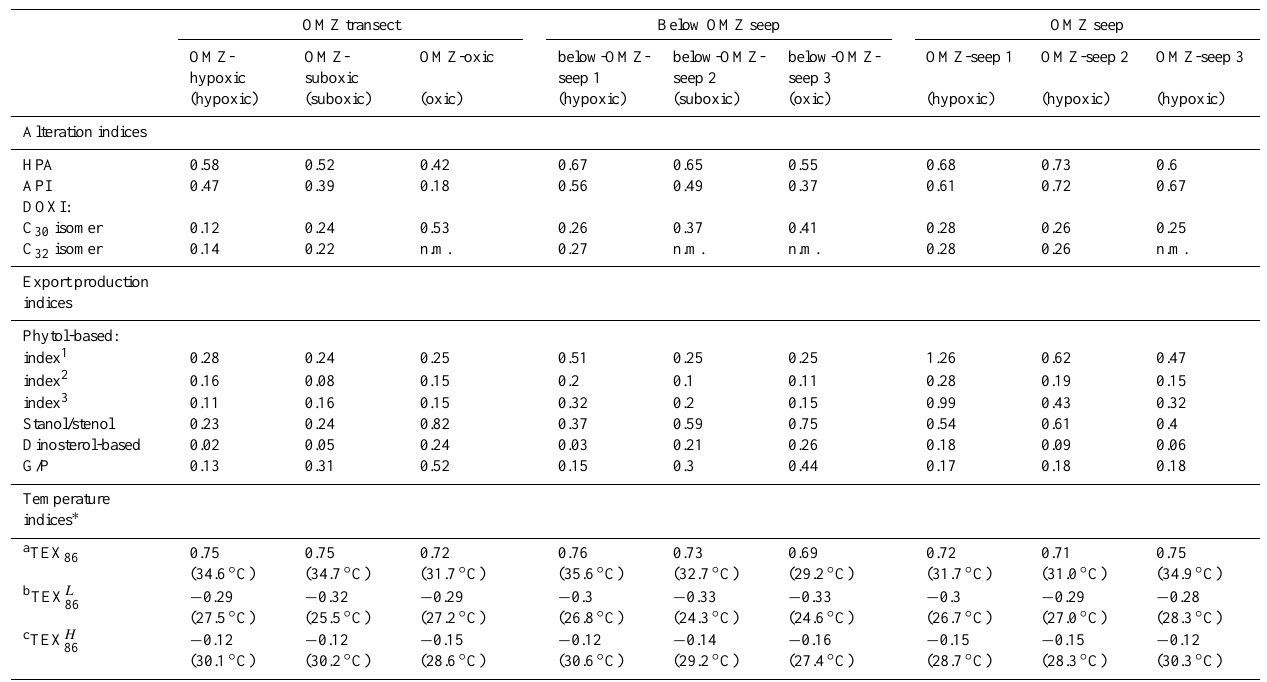
Table 4. Proxy values of the calculated indices along the three studied transects. Definitions of each of the listed indices can be found in Table 3. OMZ transect Below OMZ